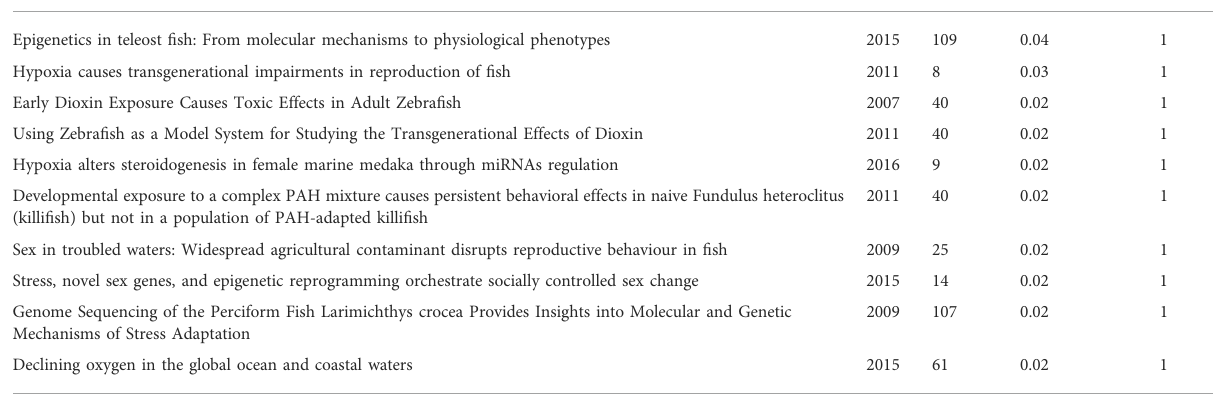
TABLE 8 Top 10 (of 117) most in fl uential publications related to research on medaka and climate change.